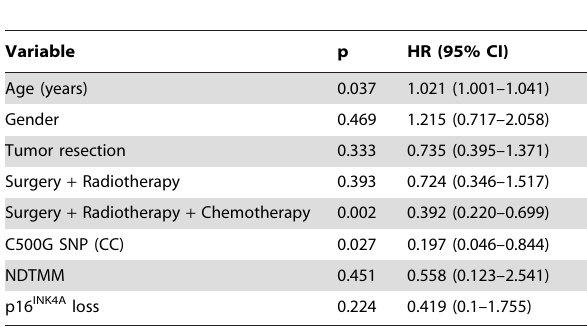
Table 3. Cox Proportional Hazards Model for Factors Affecting Survival.